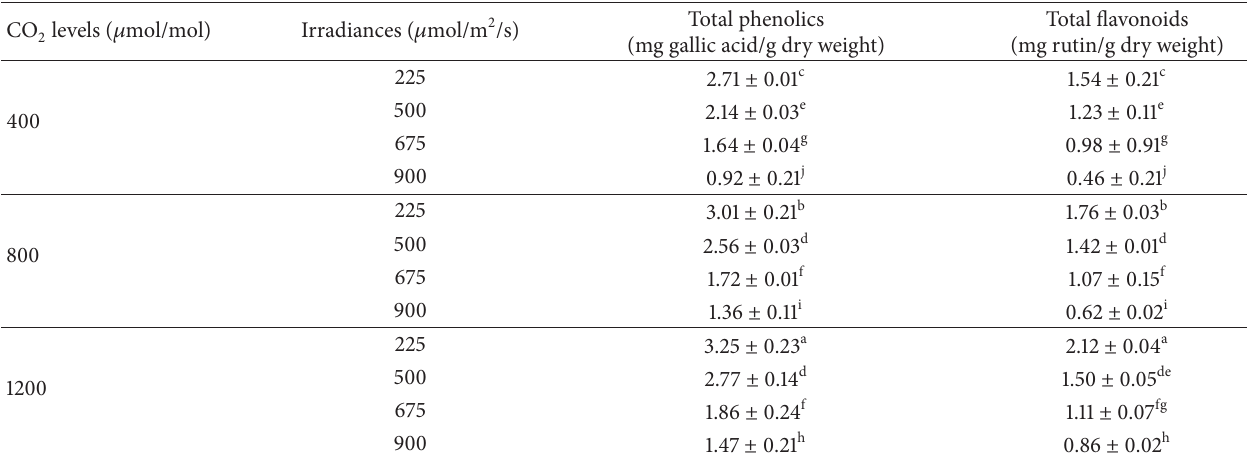
Table 1: Interaction effects of CO levels and irradiance on total phenolics and total flavonoids of Labisia pumila . 2